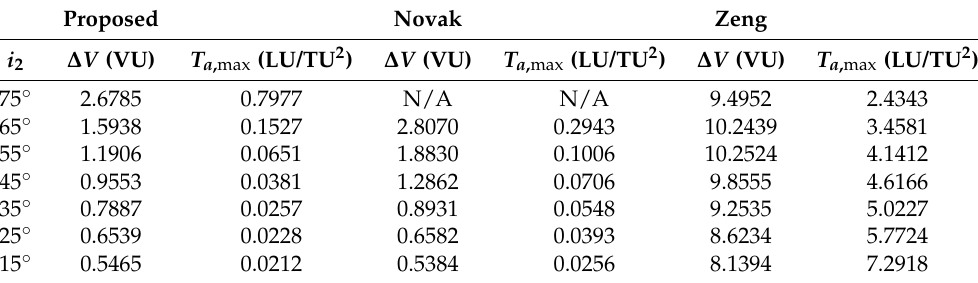
Table 4. Orbit rendezvous results with different i 2 when r 1 < r 2 .